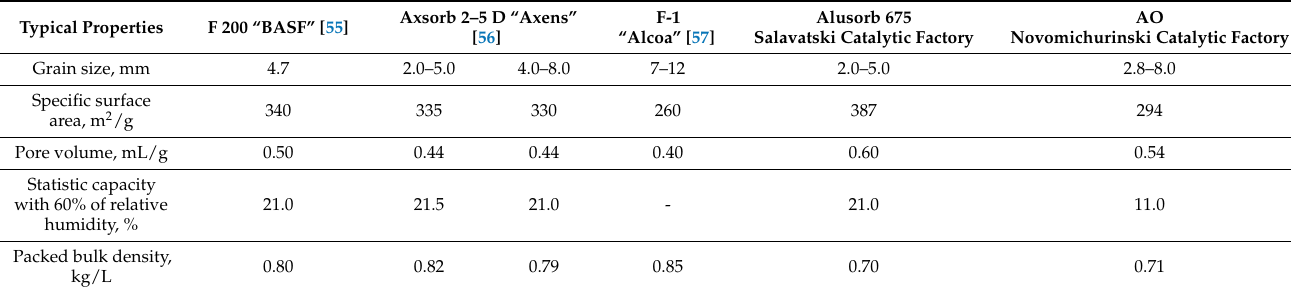
Table 2. Characteristics of some industrial adsorbents based on aluminium